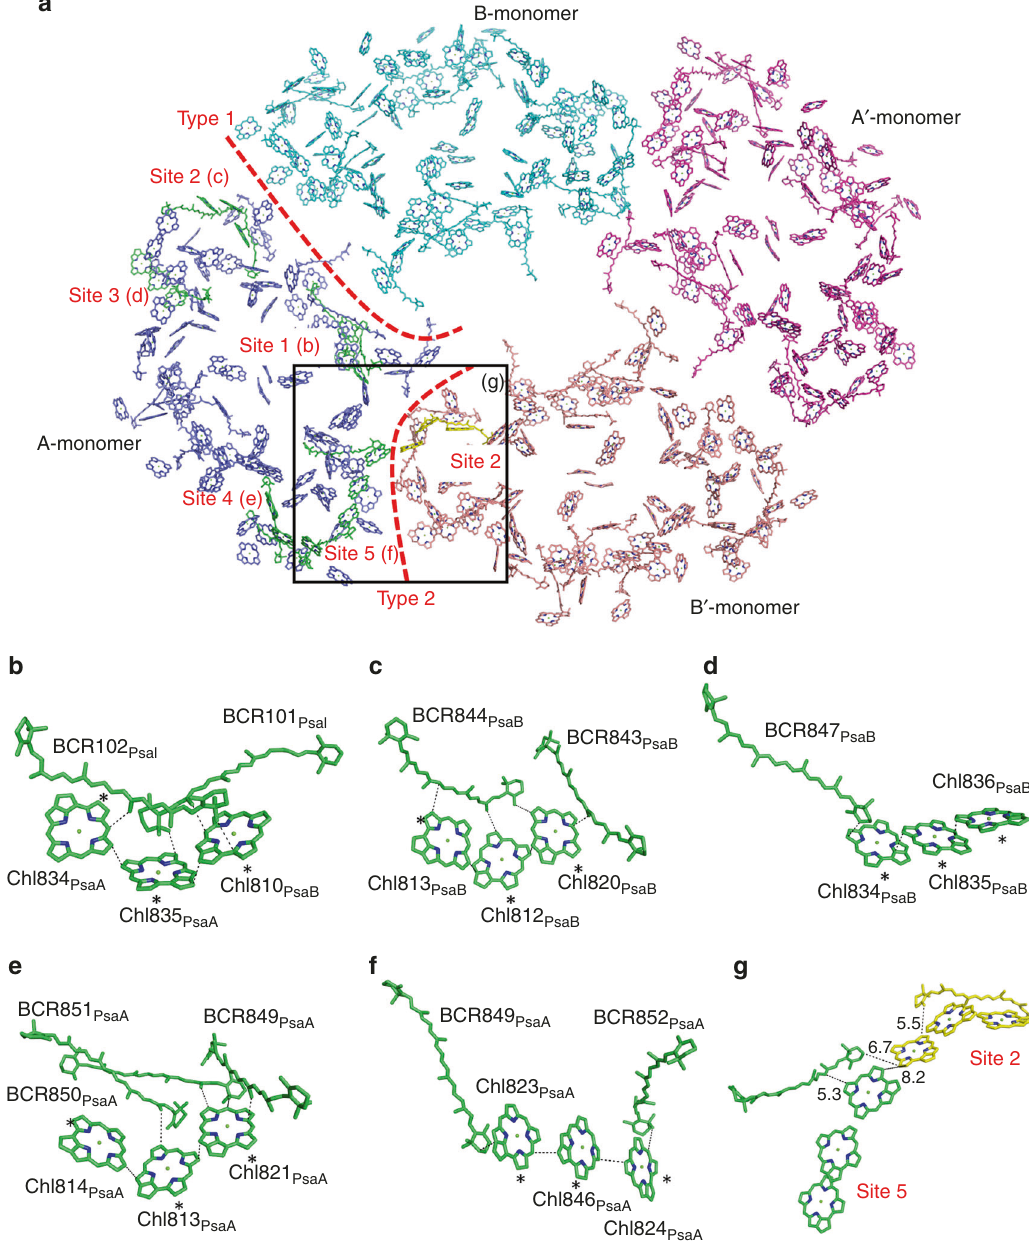
Fig. 6 Arrangement of pigments in the PSI tetramer and their interactions. a Arrangement of the pigments in the PSI tetramer viewed along the membrane normal from the stromal side. Pigments of the A-monomer, B-monomer, A ′ -monomer and B ′ -monomer are coloured in blue, cyan, magenta and pink, respectively. Triply stacked Chls in the A-monomer, and a triple Chl cluster in the B ′ -monomer that is interacting with a triple Chl cluster in the A- monomer, are coloured in green and yellow, respectively. b – f Arrangement of the triply stacked Chls of the Site 1 ( b ), Site 2 ( c ), Site 3 ( d ), Site 4 ( e ) and Site 5 ( f ), in conjunction with their nearby carotenoids. Asterisks indicate the carbon atoms that are connected with a phytol tail. g The interfacial pigments between A-monomer (green) and B ′ -monomer